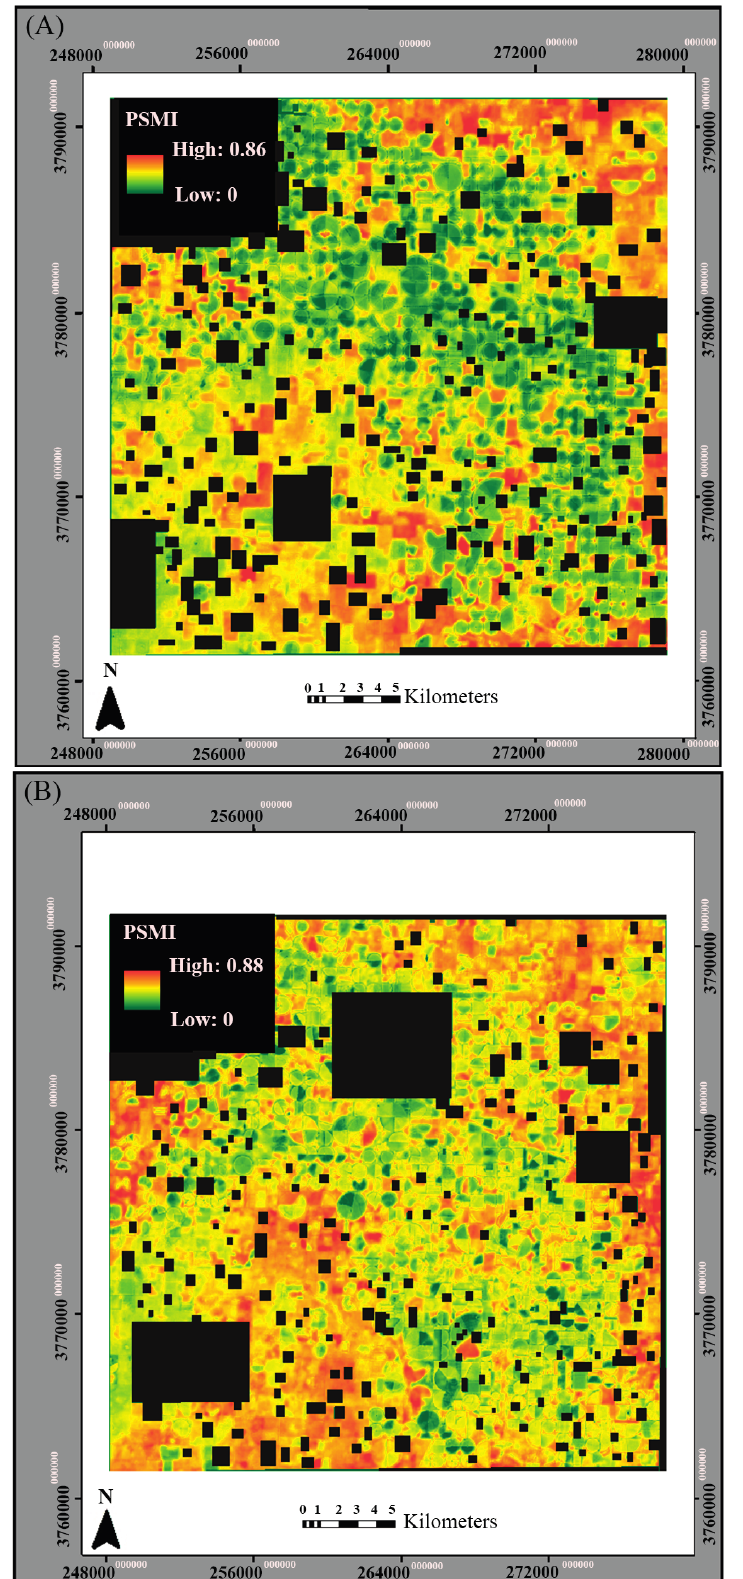
Figure 10. PSMI maps constructed for two dates for a portion of the Texas High Plains. ( A ) PSMI map for 4 August 2013; ( B ) PSMI map for 21 September 2013. Green indicates low values of PSMI (high moisture), while orange and red indicates high values of PSMI (low moisture). Urban areas, water bodies, clouds and cloud shadows are masked in